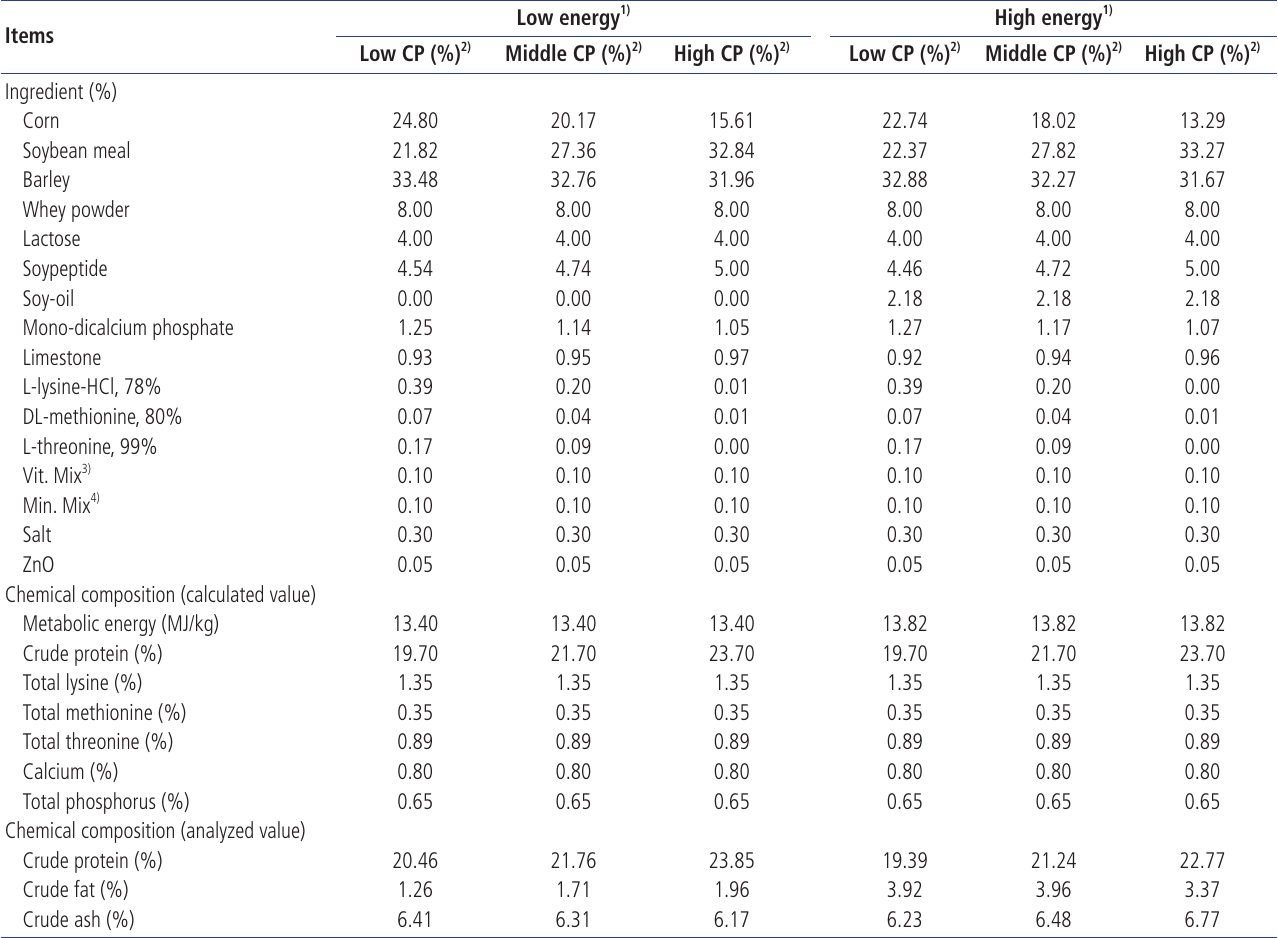
Table 1. Formulae and chemical compositions of the diets of early weaning pigs